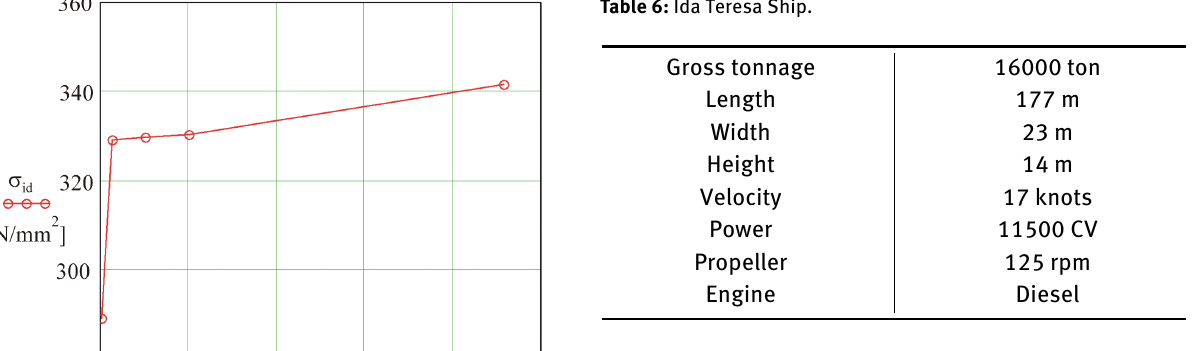
Table 6: Ida Teresa